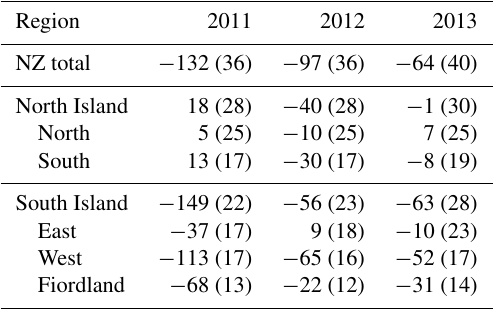
Table 1. Annual mean CO 2 flux for selected aggregated regions, in TgCO 2 yr − 1 . A negative sign indicates uptake by the land. In parentheses the a posteriori uncertainty (1 σ) is shown (excluding the sensitivity